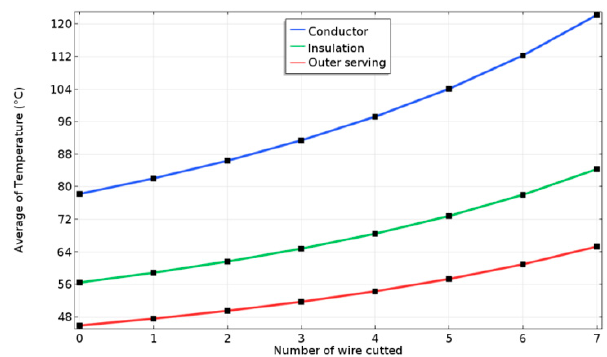
Figure 13. Average temperature in the cable as a function of number of cut wires.